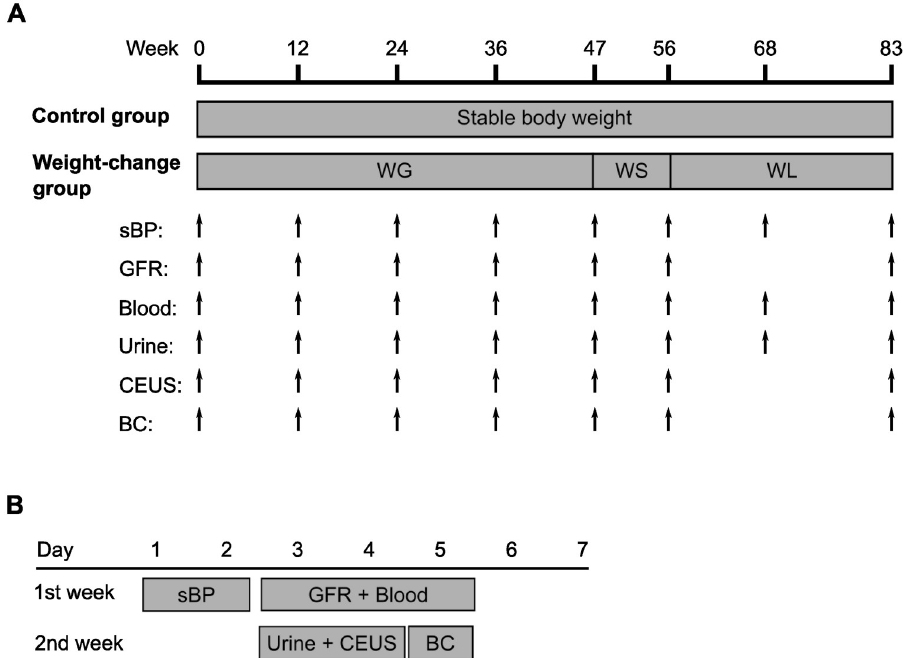
Fig 1. Schematic representation of the study protocol. (A) Summary of the sample points and timeline of the procedures used during the entire study for both the control and the weight-change groups. The control group was fed to maintain a stable body weight. The weight-gain group was fed to gain weight (WG), to remain at a stable weight (WS), and to lose weight (WL) in three consecutive phases. The procedures performed were measurement of systolic blood pressure (sBP), glomerular filtration rate (GFR), blood and urine collection, contrast-enhanced ultrasonography (CEUS) and body composition analysis (BC). (B) Timeline of the procedures during each sample point, except for week 68 when all procedures were performed within 3 days, starting measurement of sBP and ending with blood and urine